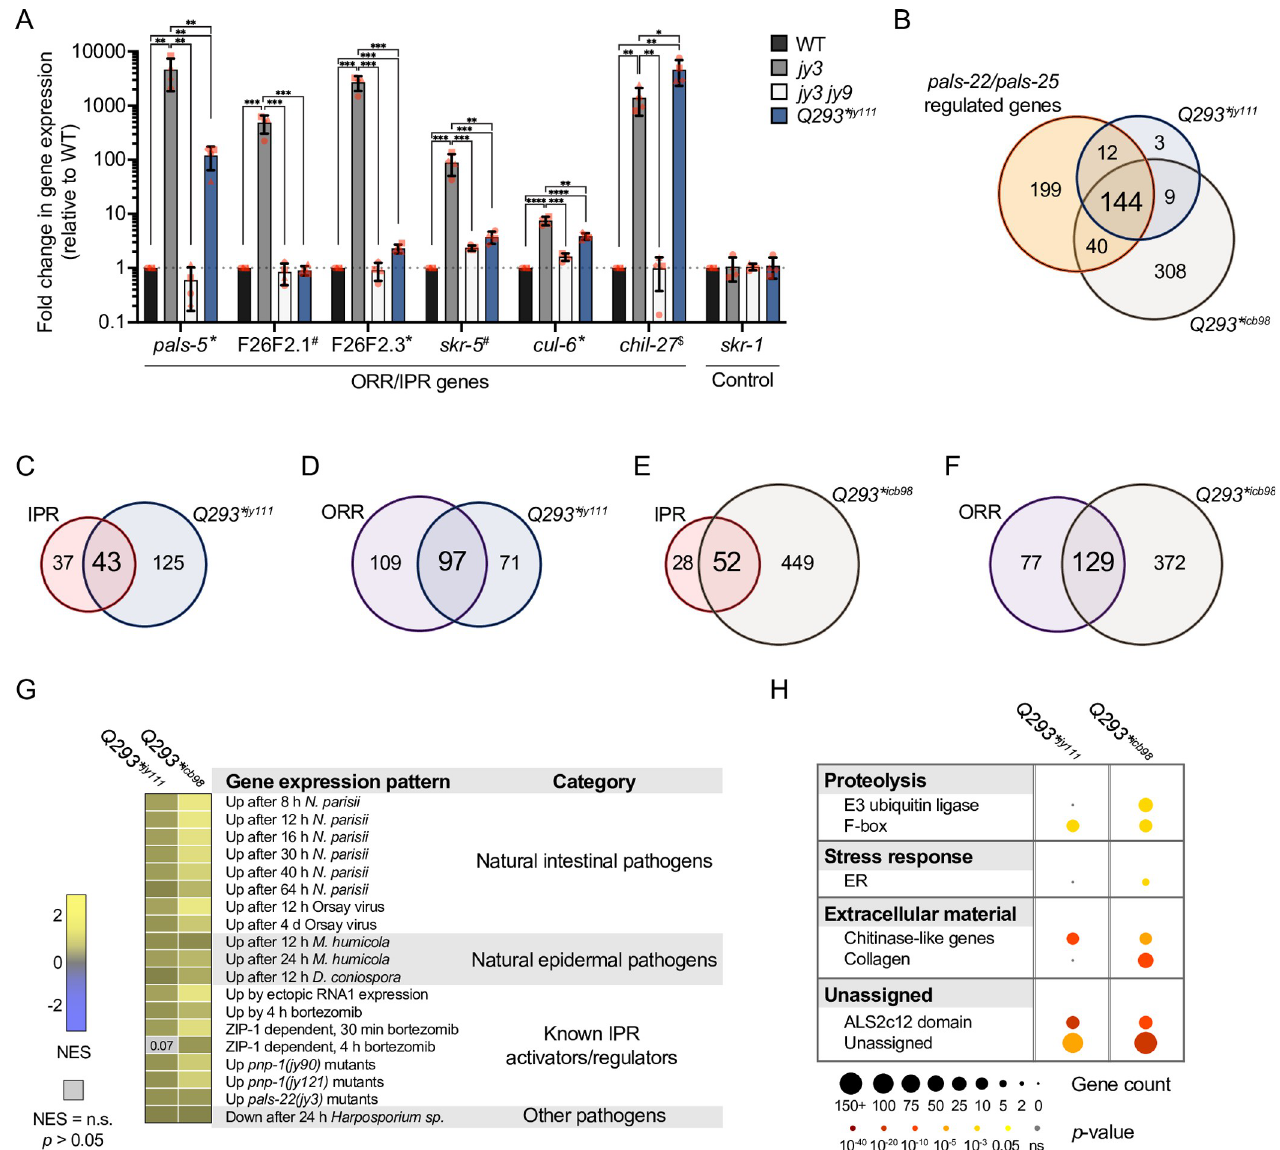
Fig 2. A subset of immune response genes is upregulated in pals-25(Q293 � ) mutants. A) qRT-PCR of select ORR and IPR genes. � = Gene belongs to ORR and IPR, # = Gene belongs to only IPR, $ = Gene belongs to only ORR. The results shown are fold change in gene expression relative to WT. ���� p < 0.0001, ��� p < 0.001, �� p < 0.01, � p < 0.05, One-tailed t-test. n = 4 independent experimental replicates, different symbol shapes represent the expression values for replicates performed on different days. Bar heights indicate mean values and error bars represent standard deviations. B) Upregulated genes in both pals-25 (Q293 � ) jy111 and pals-25(Q293 � ) icb98 mutants have significant overlap with genes regulated by wild-type pals-22 and pals-25 . Hypergeometric test, RF = 34.5; p < 5.39e-243 and RF = 15.6; p < 1.994e-182 for pals-25(Q293 � ) jy111 and pals-25(Q293 � ) icb98 , respectively. C-D) Upregulated genes in pals-25(Q293 � ) jy111 mutants have significant overlap with the IPR and ORR. Hypergeometric test, IPR: RF = 46.9; p < 6.215e-64, ORR: RF = 41.1; p < 6.883e-144. E-F) Upregulated genes in pals-25(Q293 � ) icb98 mutants have significant overlap with the IPR and ORR. Hypergeometric test, IPR: RF = 21.8; p < 4.529e-60, ORR: RF = 21; p < 5.122e-148. G) Correlation of differentially expressed genes in pals-25(Q293 � ) jy111 and pals-25(Q293 � ) icb98 mutants with those expressed during pathogen infection and regulated by known activators of the IPR. Correlation of gene sets quantified as Normalized Enrichment Score (NES) as defined by GSEAPreranked module analysis (Materials and Methods). Blue indicates significant correlation of downregulated genes in pals-25(Q293 � ) jy111 or pals-25 (Q293 � ) icb98 mutants with the gene sets tested, and yellow indicates significant correlation of upregulated genes in pals-25(Q293 � ) jy111 or pals-25(Q293 � ) icb98 mutants with the gene sets tested. Grey indicates no significant correlation ( p > 0.05 or False Discovery Rate > 0.25). GSEA analysis of 93 gene sets tested can be found in S7 Table. H) WormCat analysis shows significantly enriched gene categories represented in upregulated genes of pals-25(Q293 � ) jy111 and pals-25 (Q293 � ) icb98 mutants. Bold text indicates broad “Category 1” biological processes enriched while nested text indicates more specific “Category 2 or 3” processes enriched. p values were determined using Fisher’s exact test with Bonferroni correction from minimum hypergeometric scores calculated in the WormCat software. A summary of WormCat analysis can be found in S8 Table.